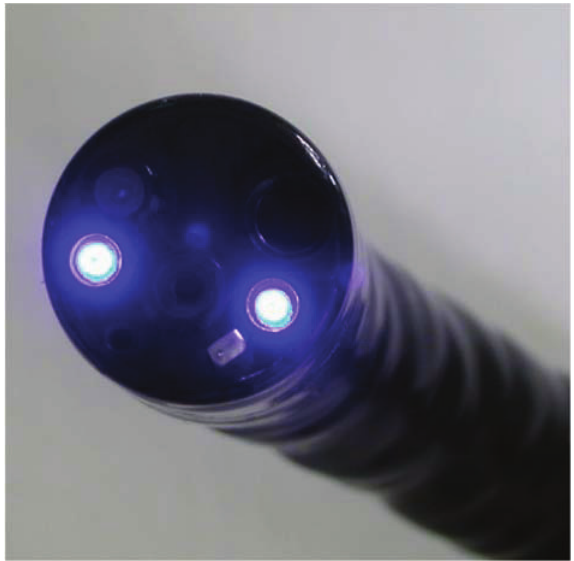
Figure 1: High-resolution videoendoscope (CF-FH260AZI) used in the autofluorescence imaging system (Olympus Medical Systems Corp, Tokyo,